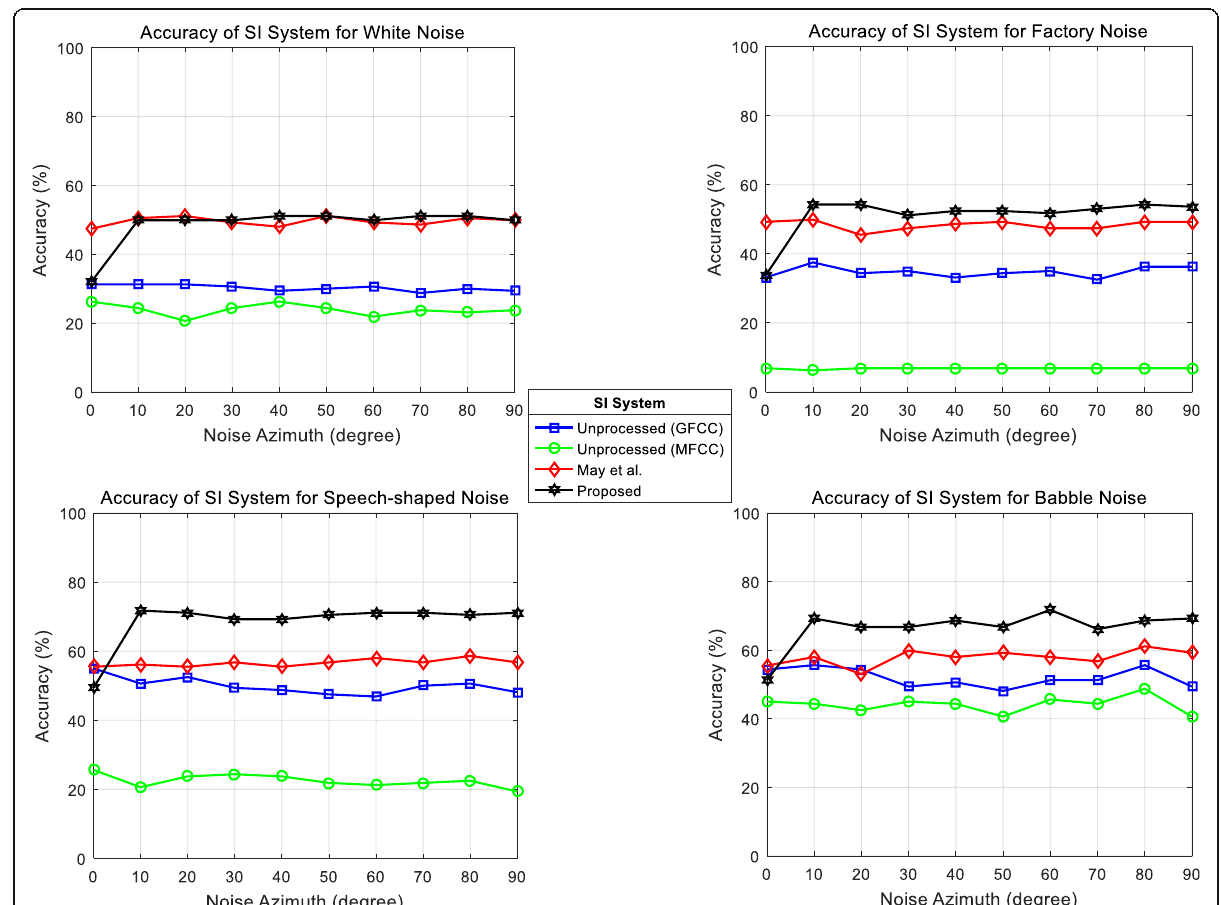
Fig. 10 The accuracy of the SI systems obtained in reverberant ( T 60 = 0.29s) and additive noise conditions with four types of noises at SNR =